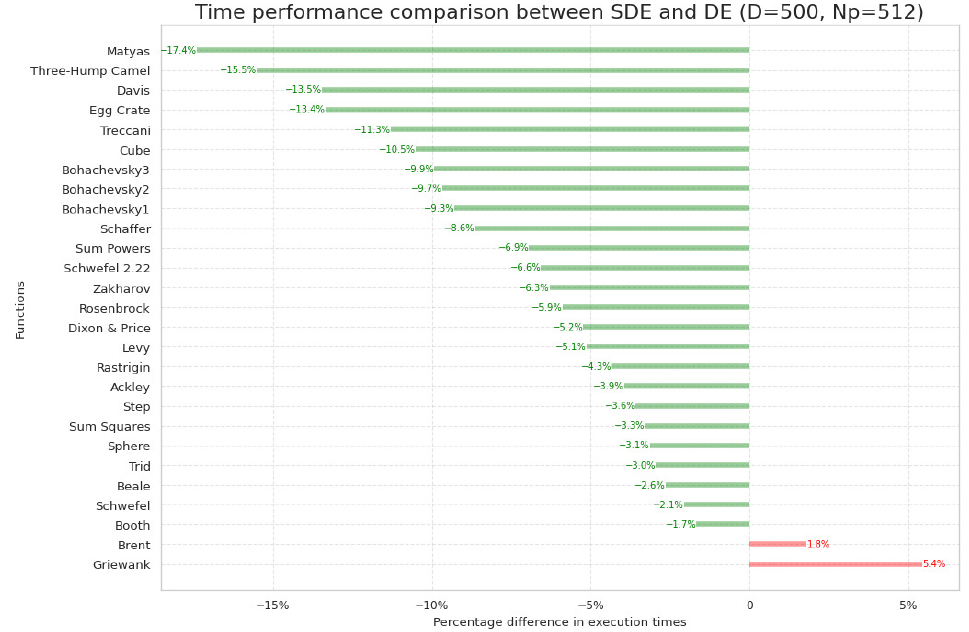
Figure 4. Percentage difference in execution times of DE and SDE for test functions with D = 500 and N p =